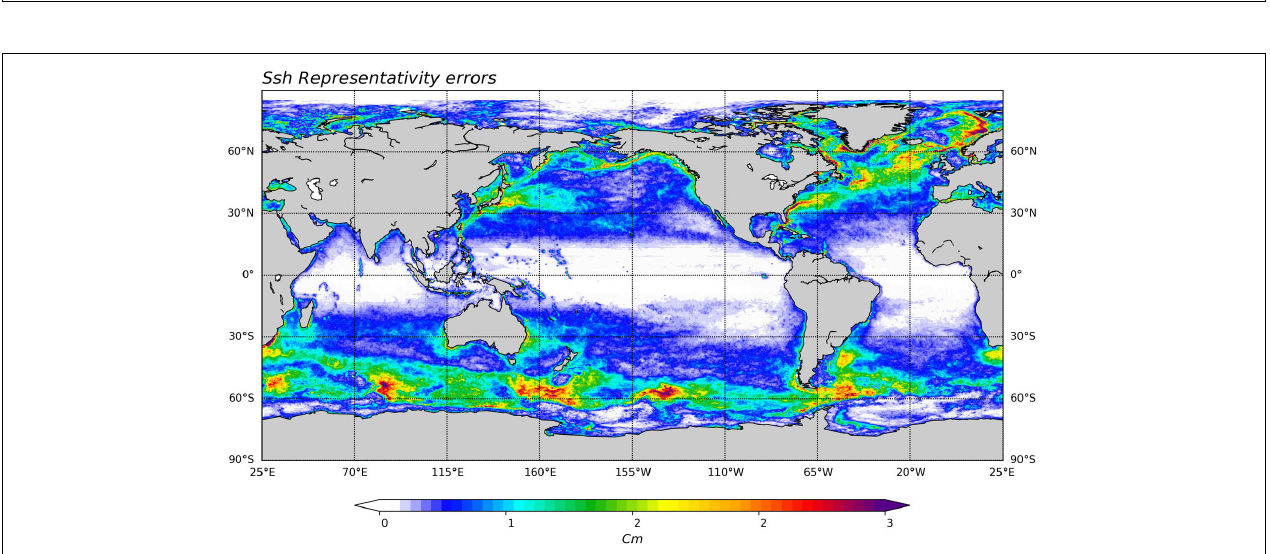
FIGURE 7 | Example of SSH pseudo-observation along a SWOT swath: (A) Pseudo-observation, (B) Pseudo-observation + noise (KaRin noise), (C) KaRIn noise along swath, and (D) standard deviation of the KaRIn noise. (E) The curves displayed show the Swot instrumental error with SWH = 2 m (wave height), considering across-swath horizontal resolution of 1 km (solid line) and 6 km (dash line).